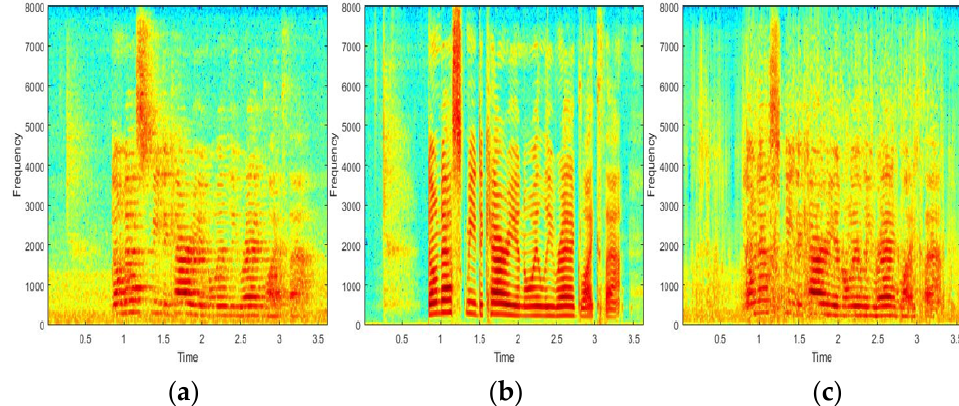
Figure 6. Waveform examples of ( a ) the recorded signal, ( b ) the signal artificially generated by RIR, and ( c ) the signal generated by the proposed method.